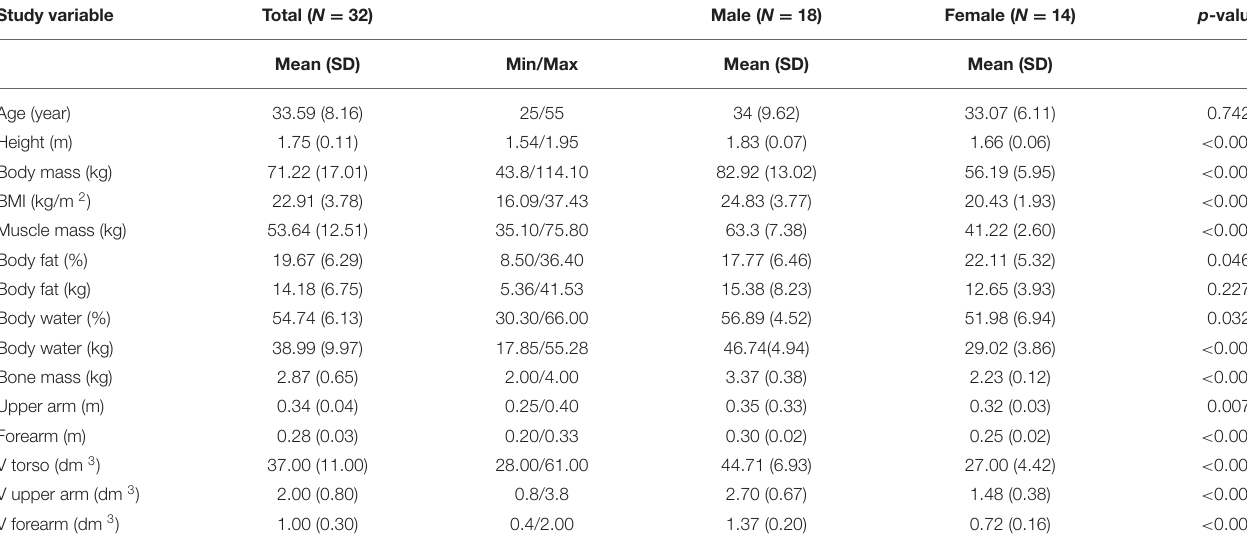
TABLE 1 | Descriptive statistics for the main characteristics of the